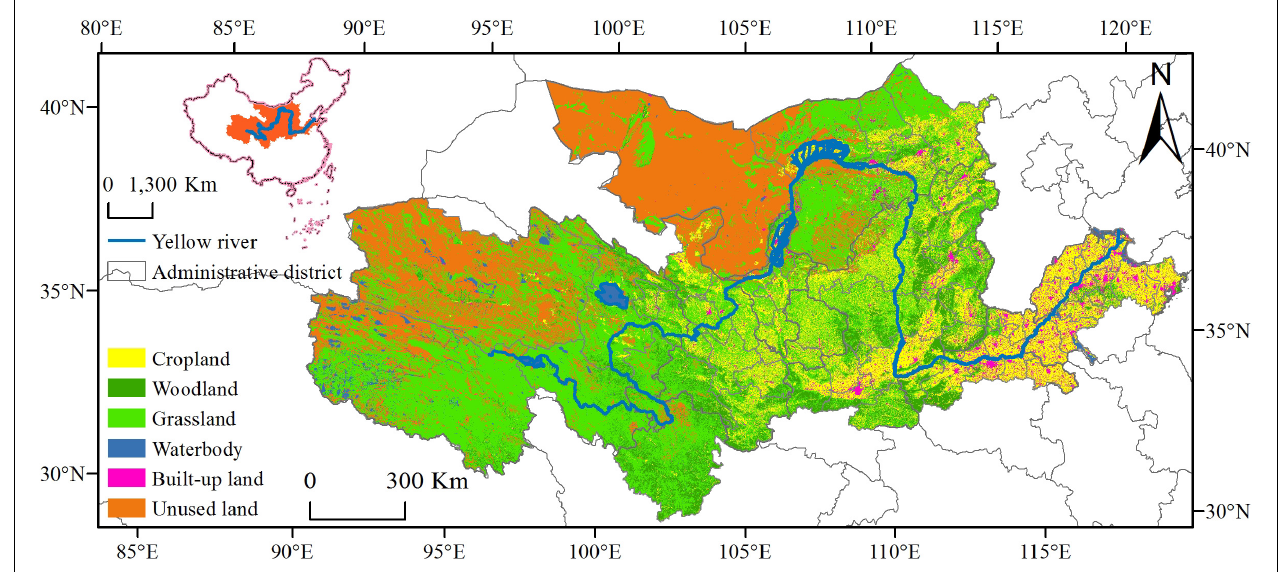
FIGURE 1 | Map of the study